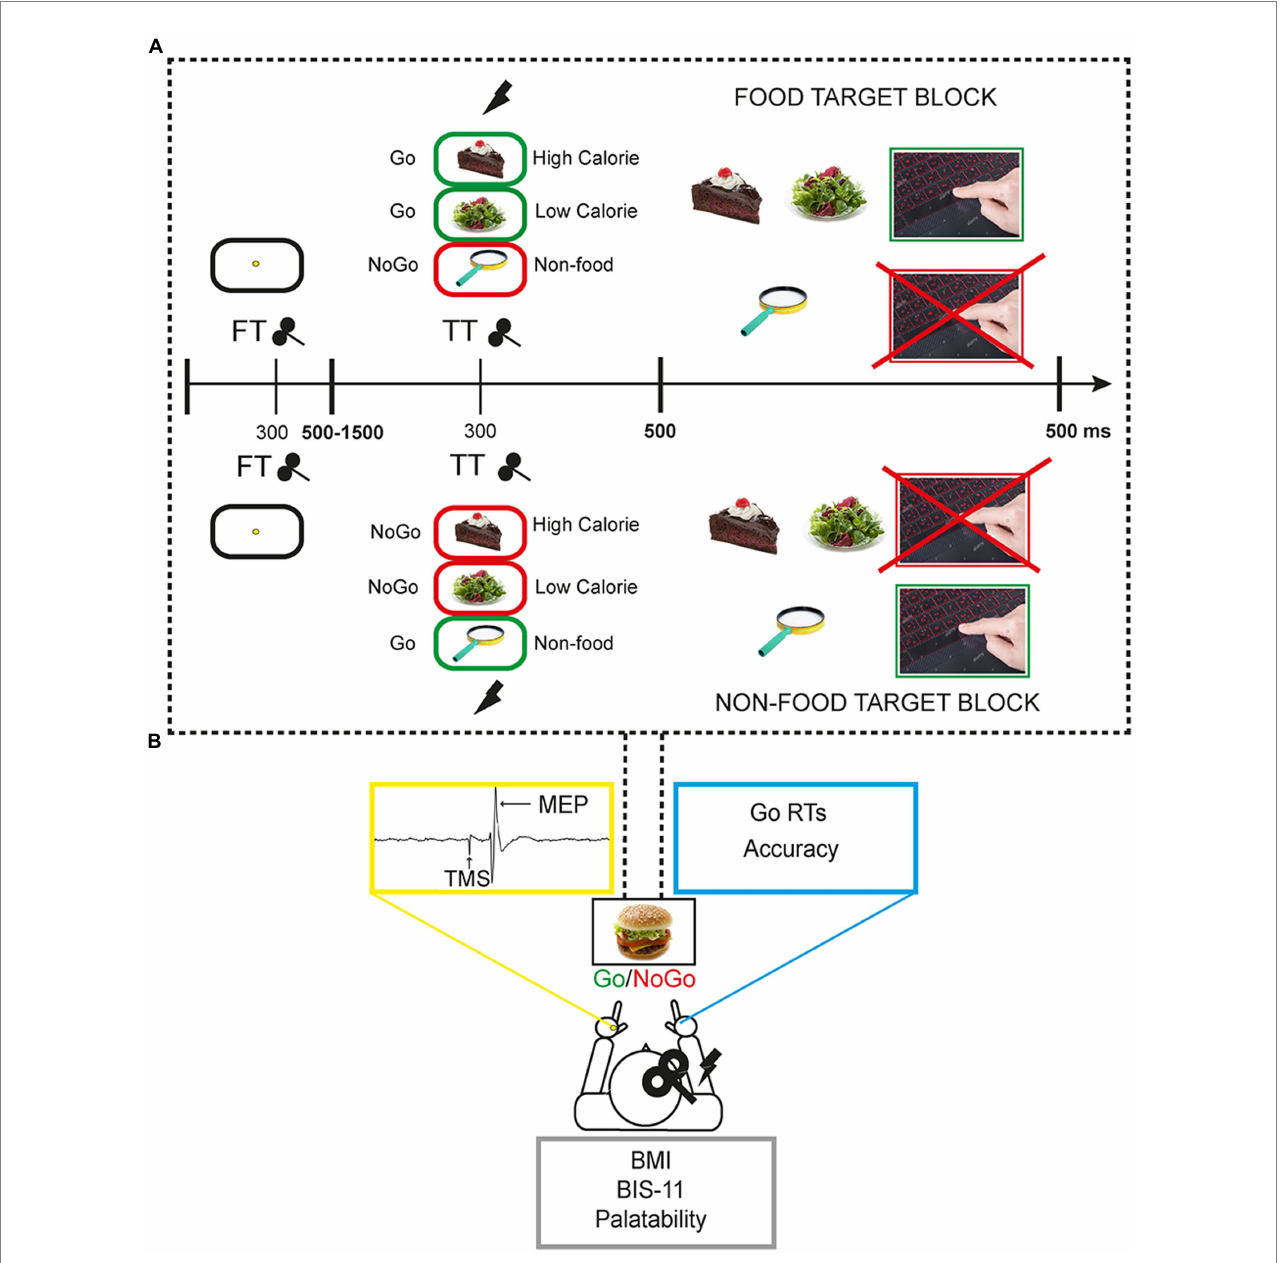
FIGURE 1 Experimental setting and behavioural task. (A) Each participant performed the task responding with the right hand whilst single pulse transcranial magnetic stimulation (spTMS) was applied over the right primary motor cortex (M1) and motor evoked potentials (MEP) were collected from the left hand. Each participant self-reported height and weight for BMI calculation, filled the Barratt-Impulsivity scale 11, and expressed its judgement about the palatability of task food images in a 5-point scale. (B) The Go/NoGo task was composed of two blocks in which participants had to alternatively respond to food or non- food stimuli.by pressing the spacebar. In FT trials spTMS was delivered 300 ms following the fixation point onset, in TT trials spTMS was delivered 300 ms following the target food/non-food target image onset. In NT trials spTMS was not